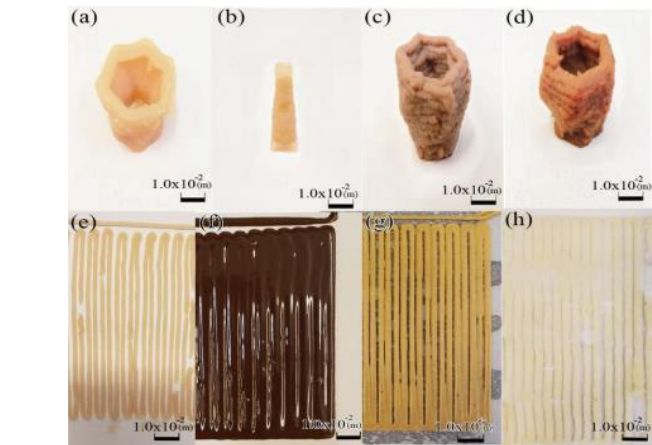
time required is ± 1.0 to 1.5 s. A speed of 1.8 × 10 − 2 m/s turned out to be the most stable head speed.